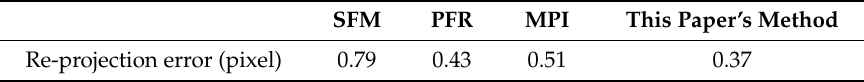
Table 1. Comparison of different orientation methods’ re-projection error.